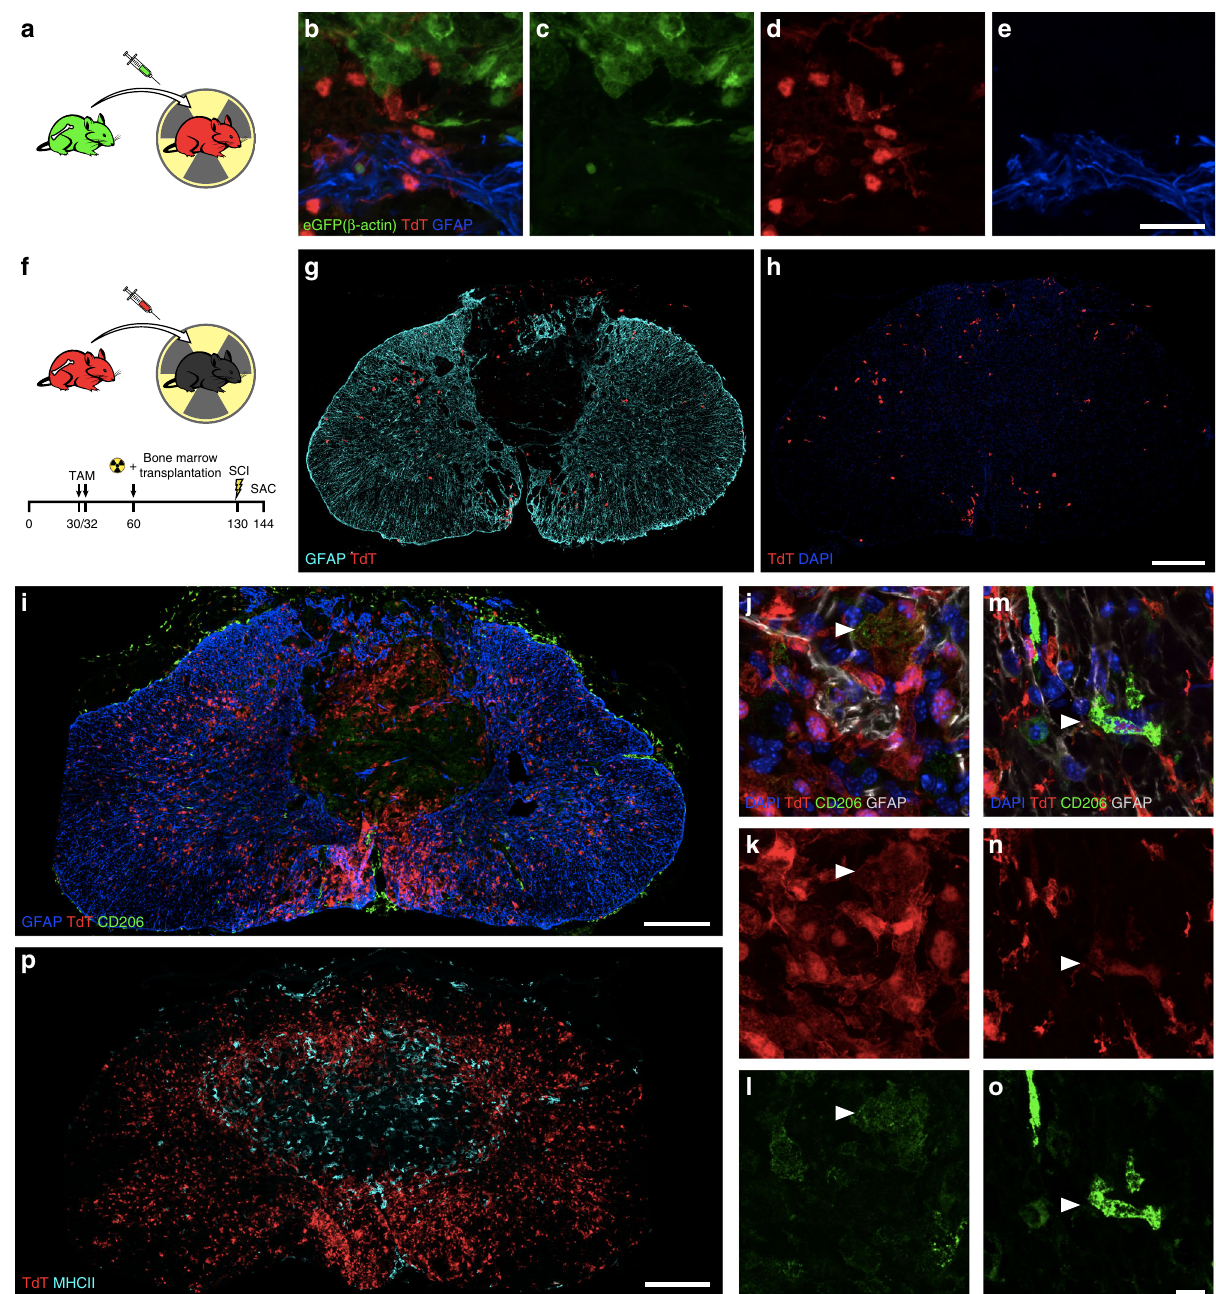
Fig. 5 The microglial scar is mainly composed of microglia, with few scattered blood-derived myeloid cells and CNS border-associated macrophages. a Schematic diagram showing the protocol used to generate radiation bone marrow chimeras in which microglia express TdT and bone marrow-derived cells the GFP reporter. b – e Representative confocal images showing the microglial scar formed of TdT + microglia (red), some of which are in close apposition with GFAP-immunoreactive astrocyte endfeet (blue) on one side and bone marrow-derived cells (eGFP + , green) on the other side at 14 days post-SCI. f Schematic of experimental procedure and timeline to generate bone marrow chimeras in which Cx3cr1 creER :: R26-TdT mice were used as bone marrow donors for irradiated recipient C57BL/6 mice. g and h Representative confocal images showing the virtual absence of bone marrow-derived TdT + cells (red) medial to the astrocytic scar (as de fi ned by GFAP + astrocyte endfeet in blue), where the microglial scar normally develops, at 14 days post-SCI in Cx3cr1 creER :: R26-TdT → WT chimeric mice. i – o Confocal images showing the absence (or very weak expression) of CD206 (green) in microglia (TdT + , red) forming the microglial scar at the lesion borders at 14 days post-SCI. In contrast, border-associated macrophages express high levels of the CD206 protein. p Representative confocal image showing the absence of colocalization between TdT (red) and MHCII (cyan) in the injured spinal cord of a Cx3cr1 creER :: R26 - TdT mouse at 14 days. Scale bars: ( b – e , in e ) 20 µ m, ( g and h , in h ) 200 µ m, ( i , p ) 200 µ m, ( j – o , in o ) 10 µ